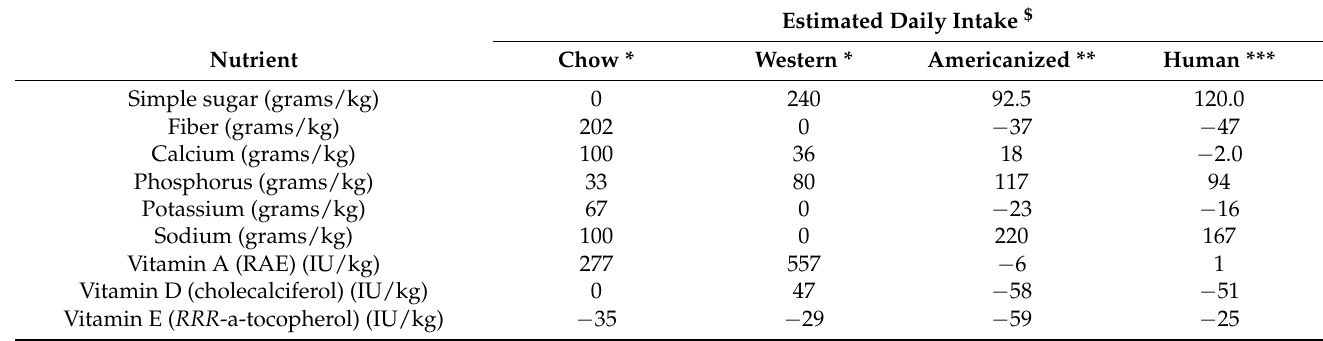
Table A1. Calculating target values for nutrients in experimental diets.